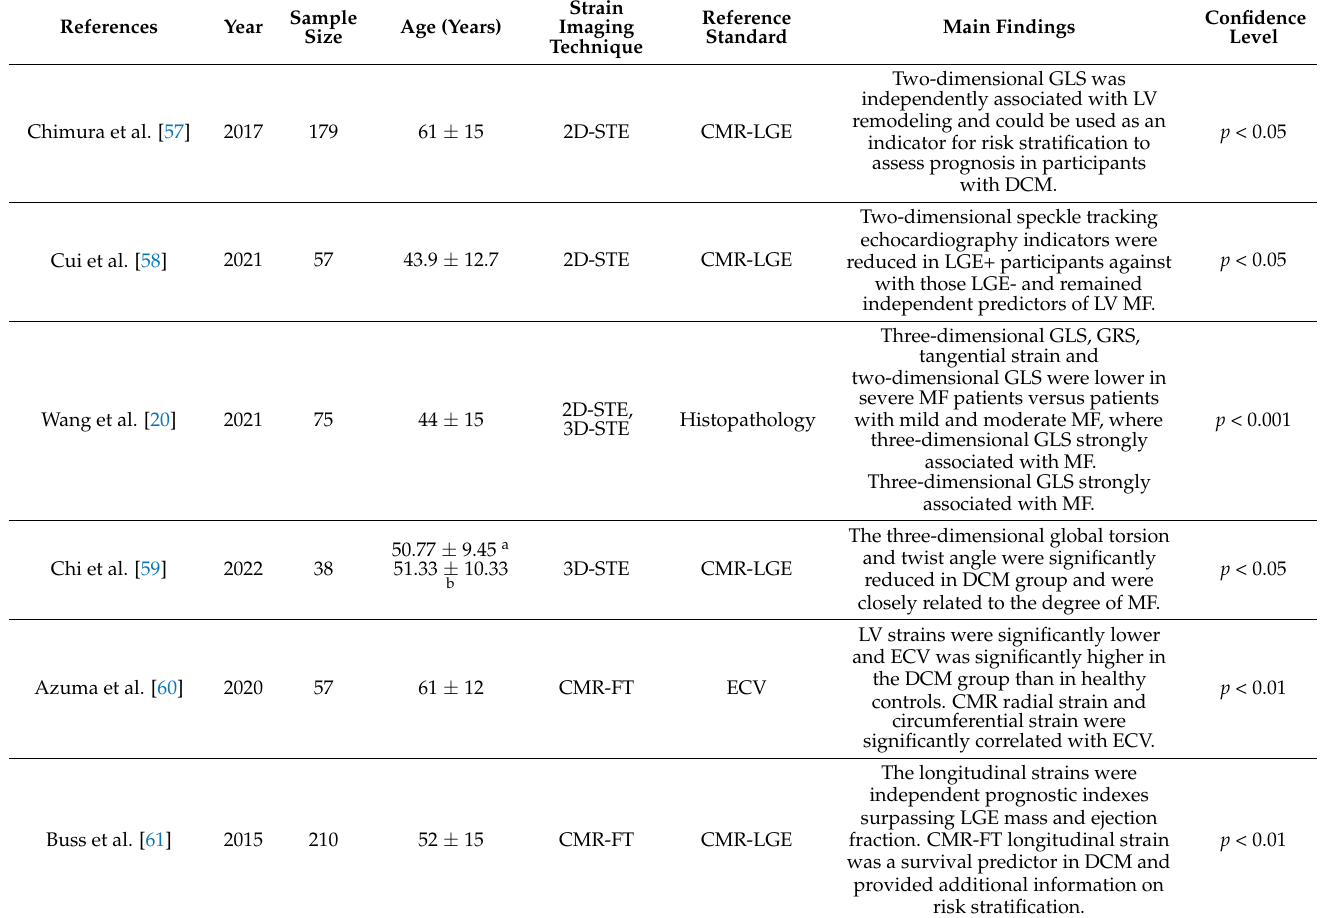
Table 2. Evaluation of MF in DCM patients using strain